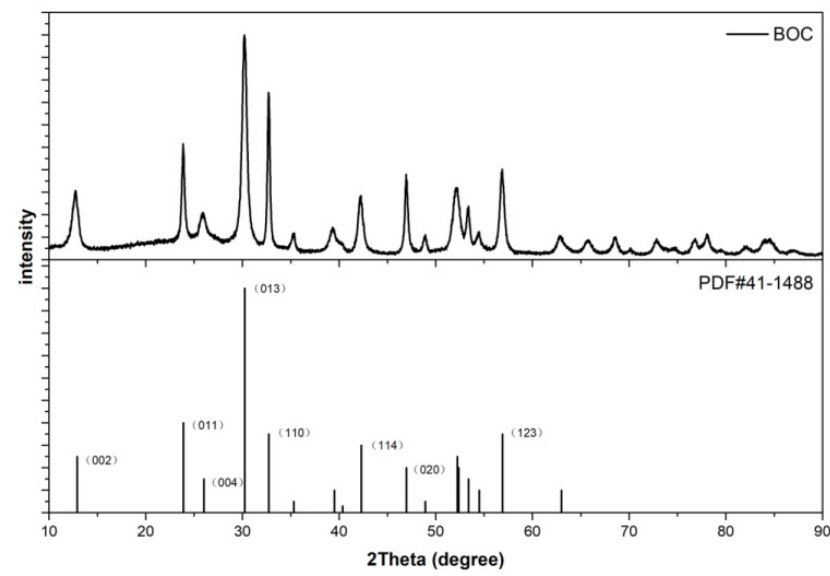
Figure 2. XRD patterns of the as-synthesized Bi 2 O 2 CO 3 .